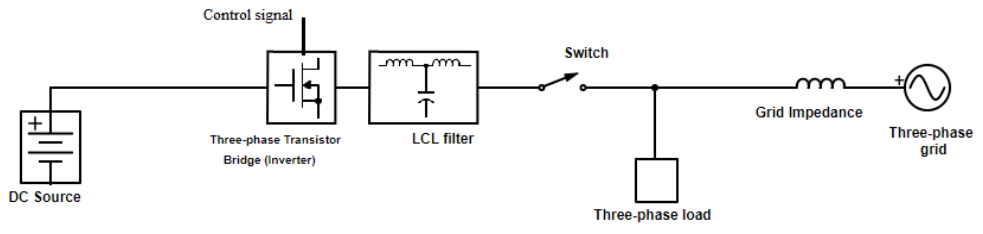
Figure 8. Test system single-line block